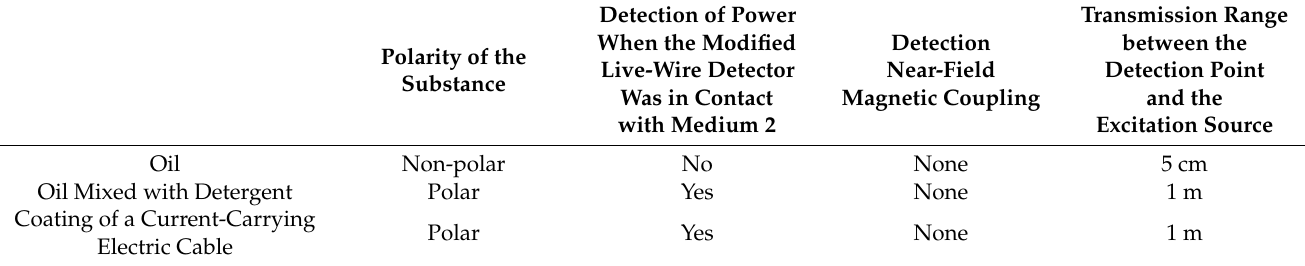
Table 1. Measured results when a non-water substance was used as medium 2.